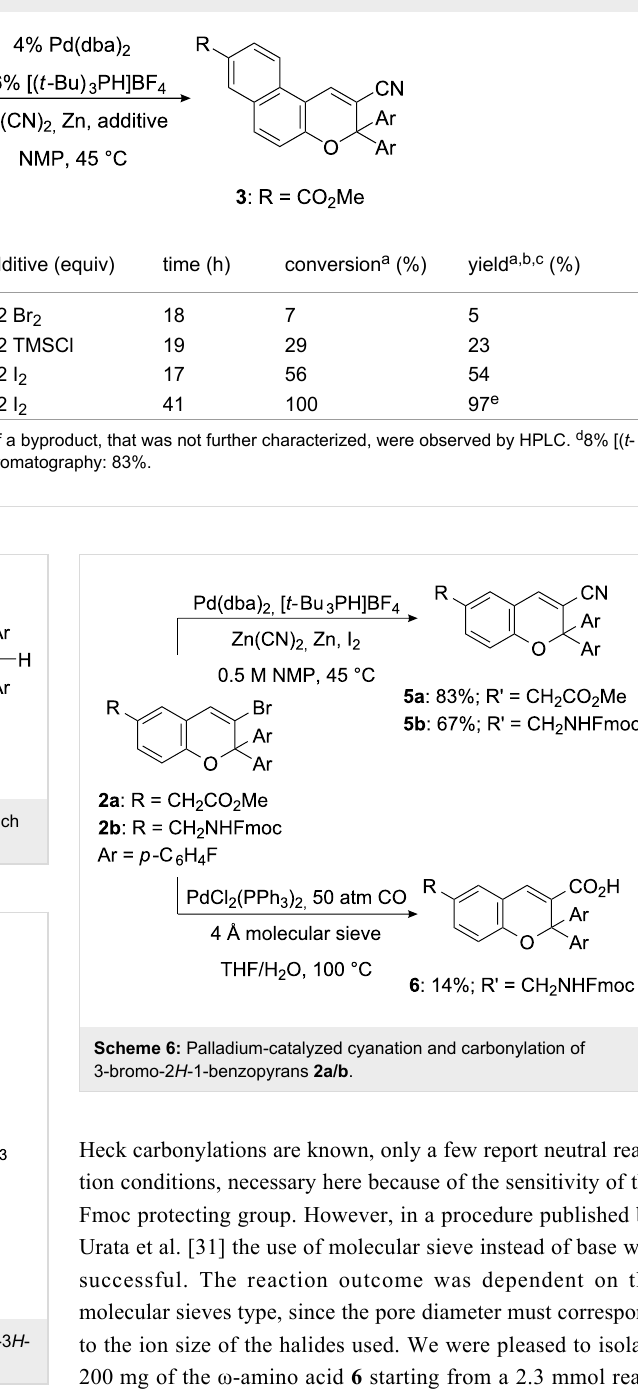
Table 1: Optimization of palladium catalyzed cyanation reactions with Zn(CN) 2